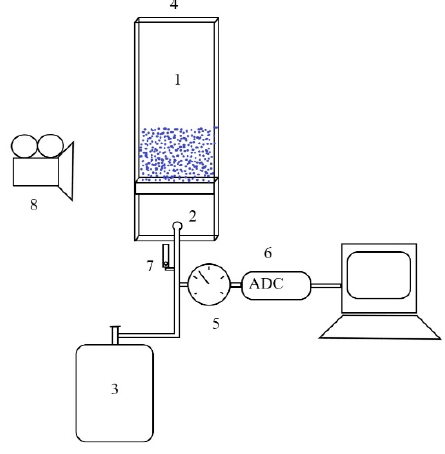
Figure 6. System for laboratory experiments.